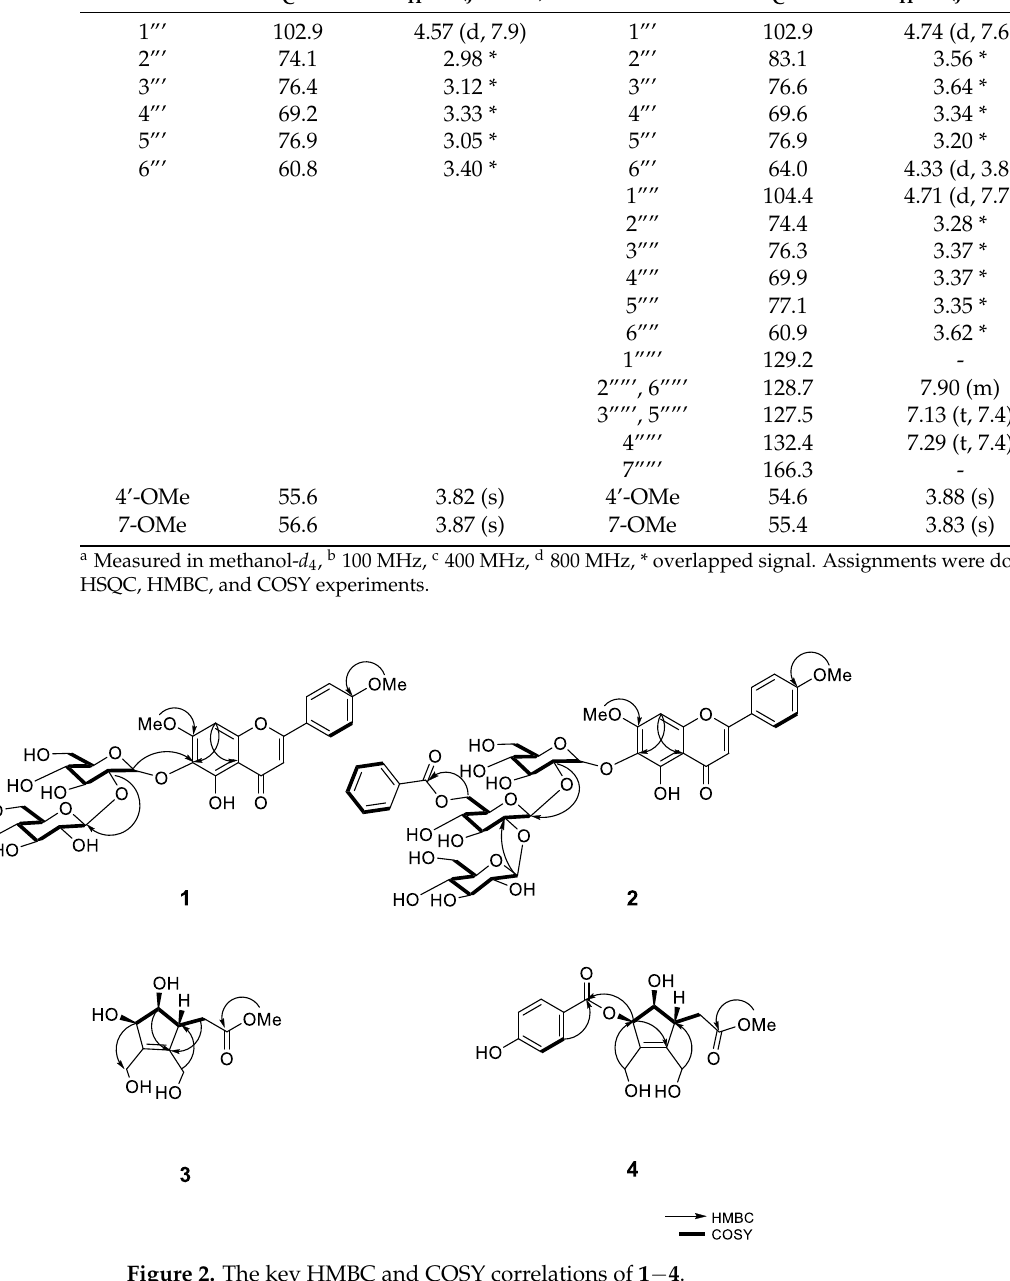
Figure 3. The key NOESY correlation of compounds 3 and 4 . Figure 4. CD spectra of compounds 3 and 4 . Table 1. NMR spectroscopic data for compounds 1 and 2 .